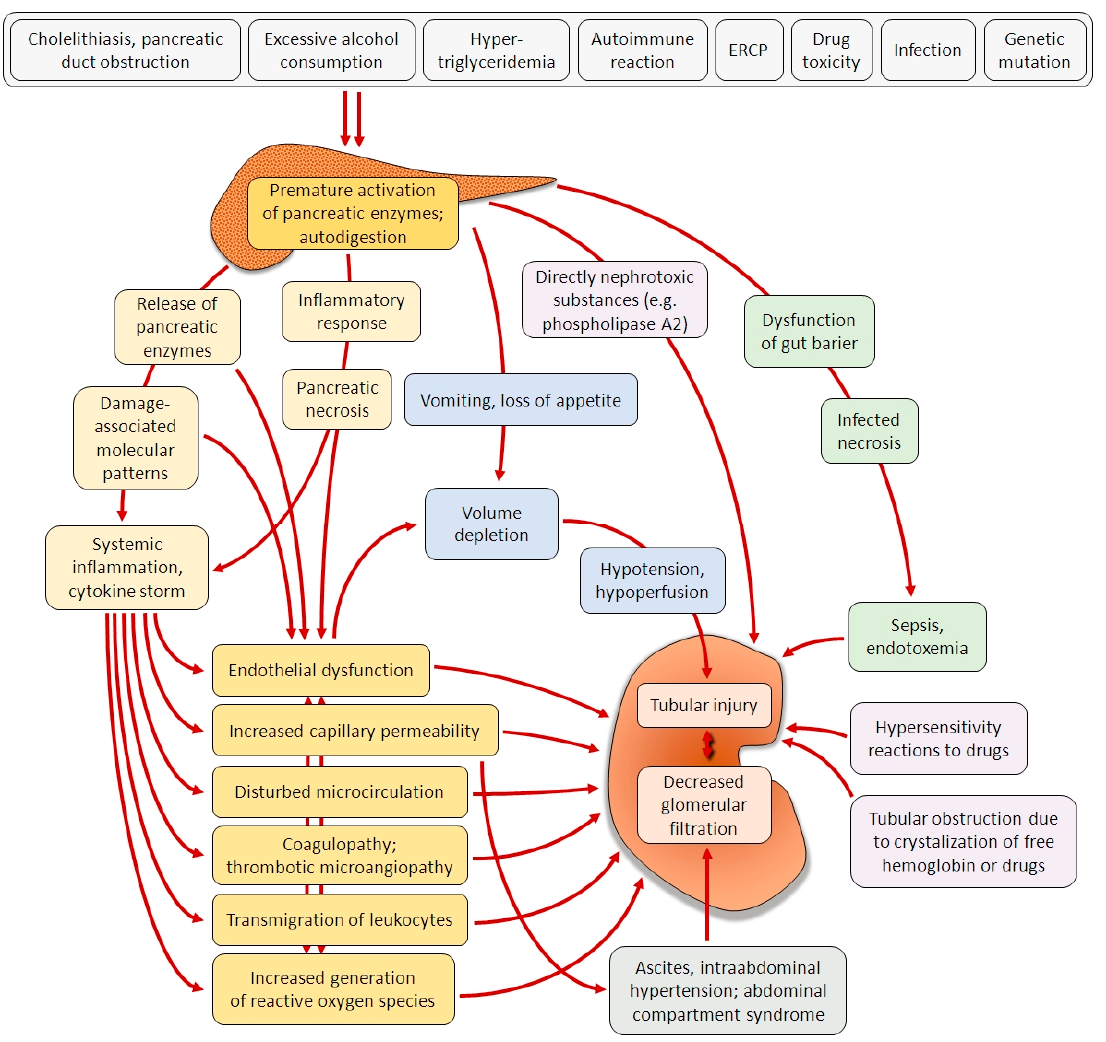
Figure 1. Pathophysiological factors influencing the development of AKI in AP.